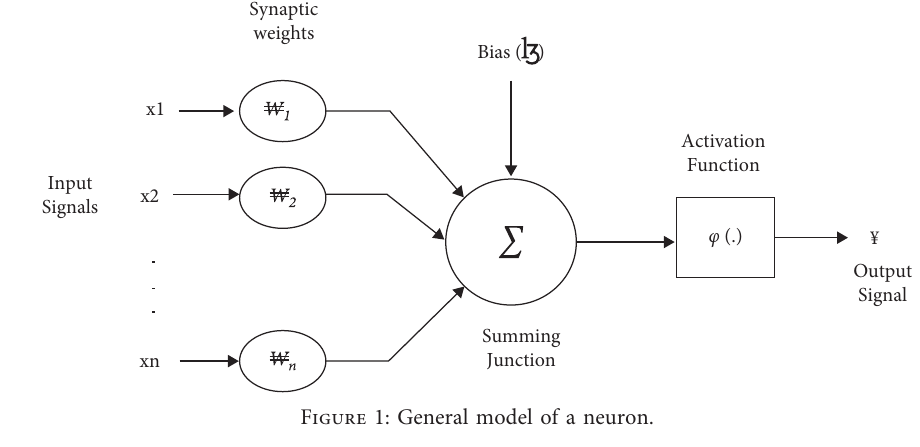
Figure 1: General model of a